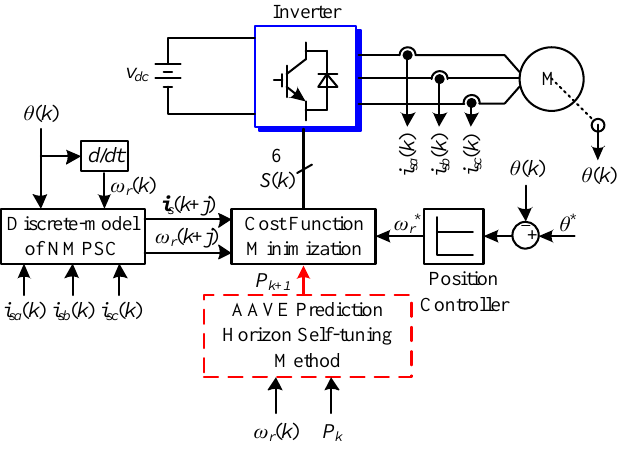
Figure 5. Structure of PMSM rotor position system with the proposed method. Table 1. Main parameters of PMSM.